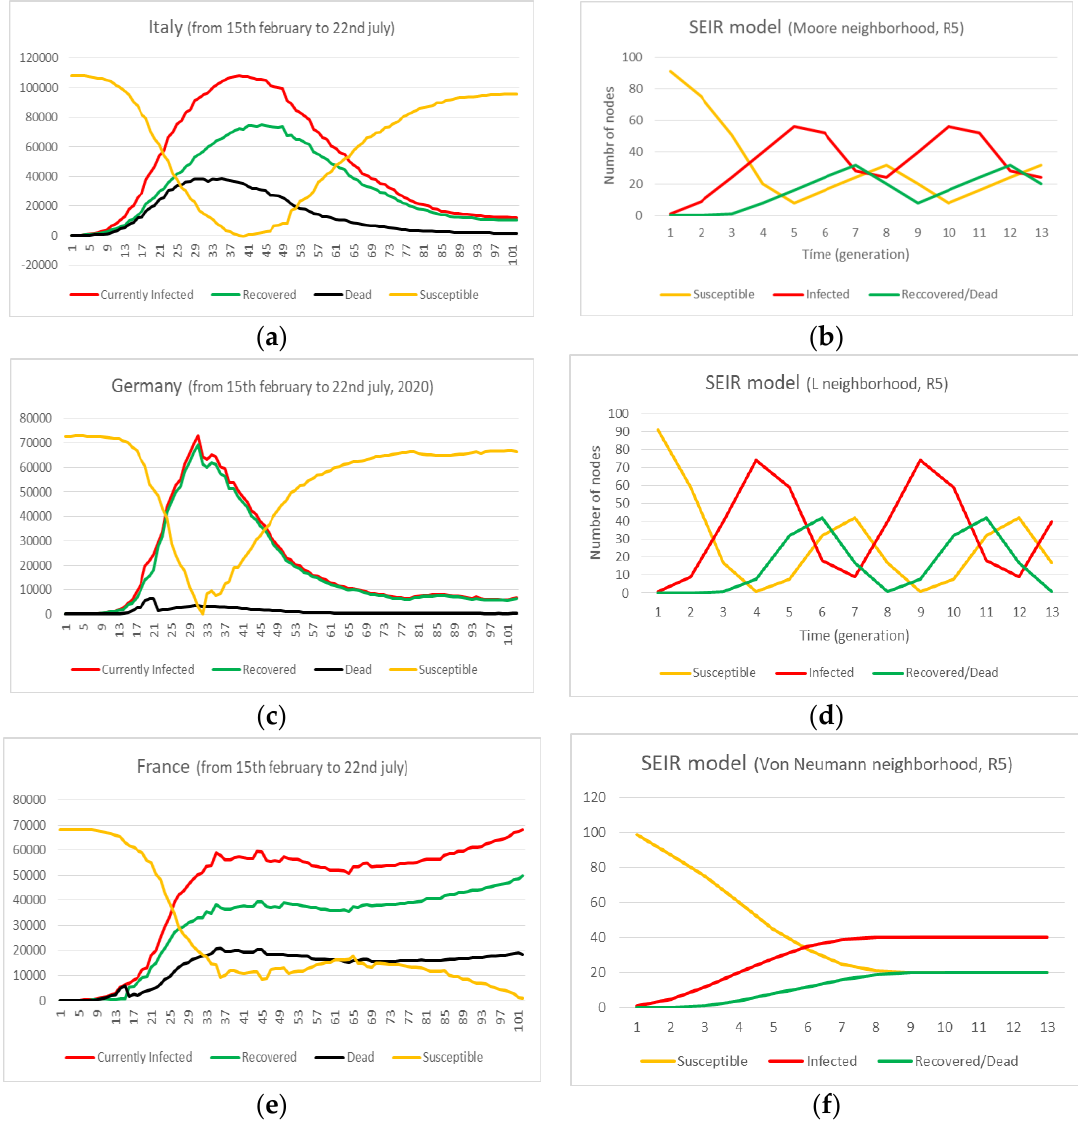
Figure 3. The situation of Covid-19 spread in Italy, Germany and France ( a , c , e ). The simulation of Susceptible, Currently Infected, Recovered/Dead by means of a Susceptible–Exposed–Infected–Recovered/Dead (SEIR) model, ( b , d , f ).